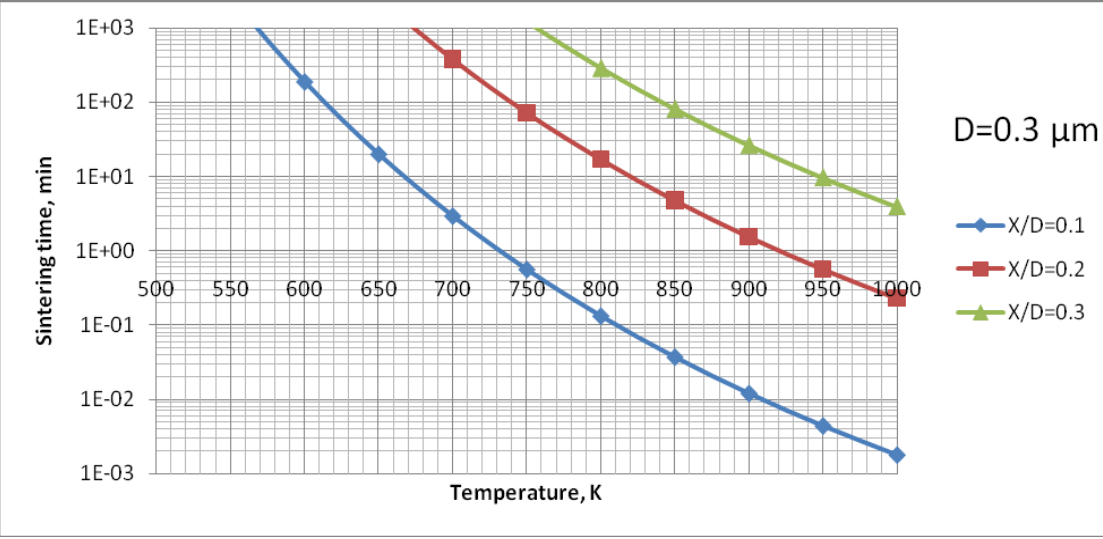
Figure 10. Sintering time of TiO particles having initial diameter of 0.3 µm to reach the 2 necks diameter ranging from X/D = 0 to X/D = 0.1; 0.2 or 0.3 vs. temperature for surface diffusion mechanism of